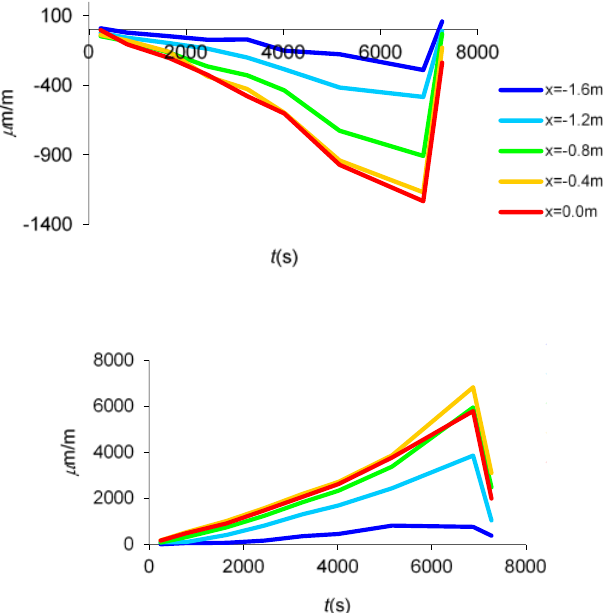
Figure 11. FOS strain measurements at di ff erent loading stages along the beam length: FOS #1 ( up ), FOS #2 ( down ).